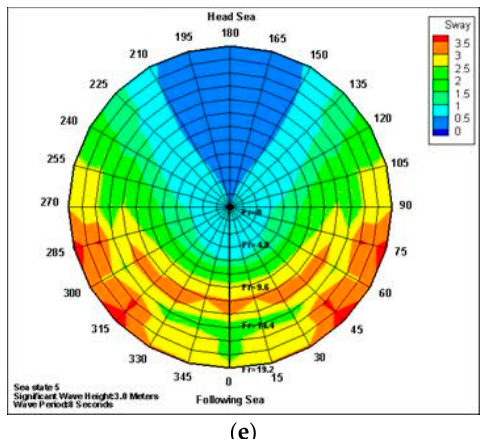
Figure 11. Speed polar diagrams of swaying motion in combination with sailing speeds and wave heading angles under sea states of ( a ) 1, ( b ) 2, ( c ) 3, ( d ) 4, and ( e ) 5, respectively.